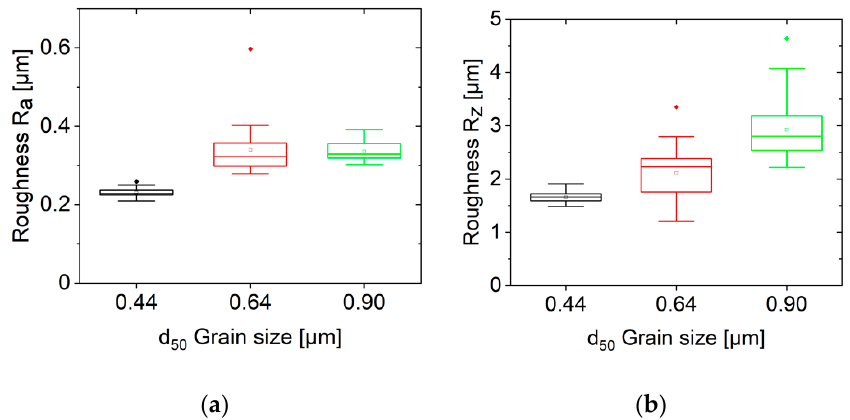
Figure 9. Surface roughness parameters measured on the substrates of O1, HT1350 and HT1400 with different d 50 -grain sizes ( a ) R a ; ( b ) R z .